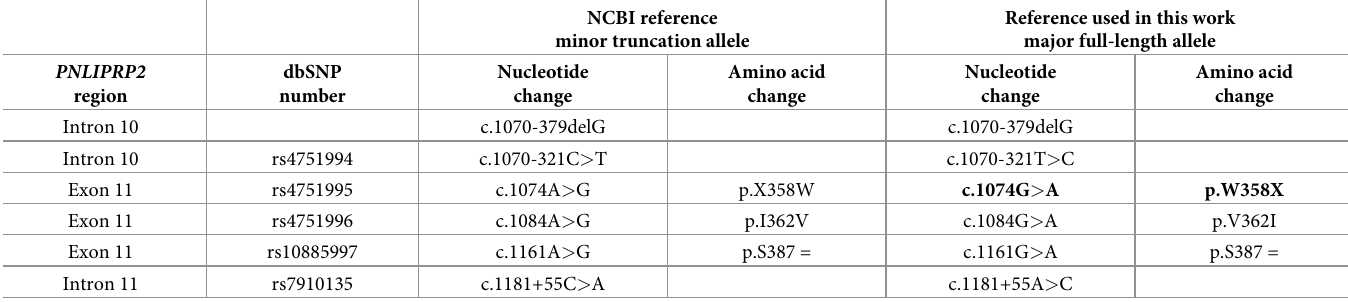
Table 1. Designation of PNLIPRP2 variants with respect to the NCBI reference sequence corresponding to the minor truncation allele and the full-length major allele used as the reference in this study.